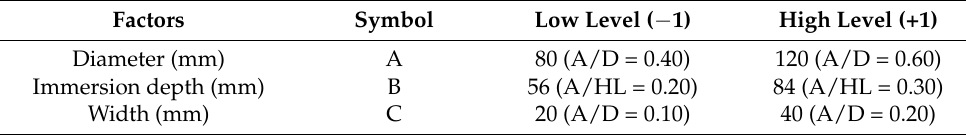
Table 1. Factors and their levels for the 2 3 full-factorial design. Factors Symbol Low Level ( − 1) High Level (+1) Diameter